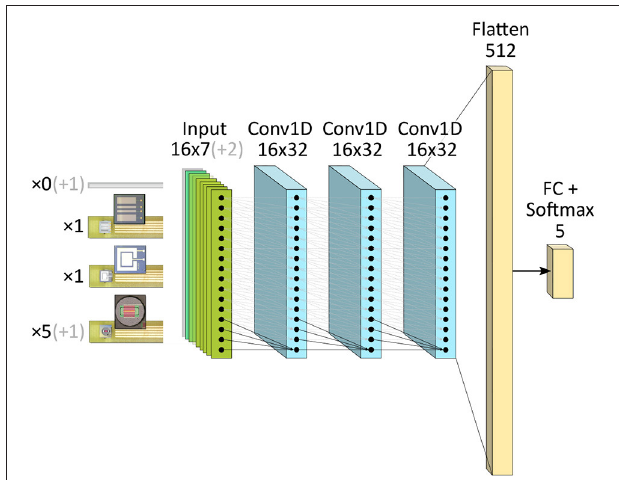
FIGURE 5 | Causal CNN architectures implemented in the work. Opaque channels depict the final seven-sensor configuration deployed on all benchmarked systems. Transparent channels the additional sensor inputs originally used to classify the beverages from all nine